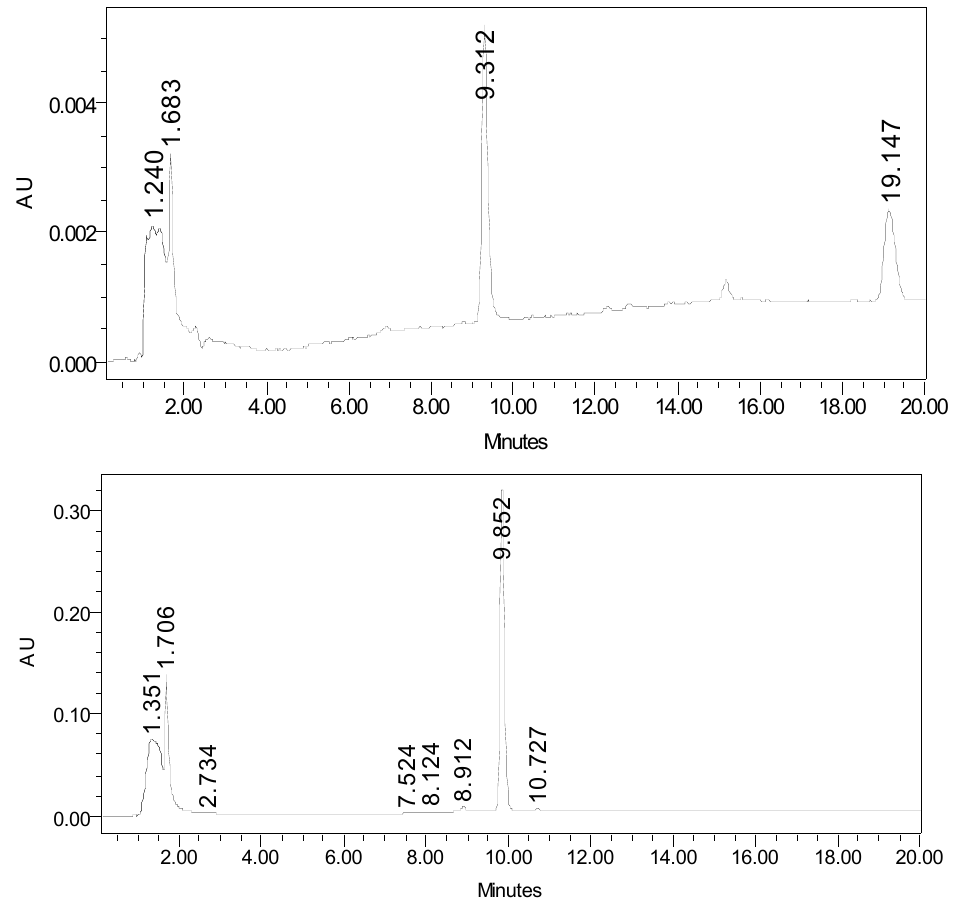
Figure 1. HPLC chromatogram of 1-AP, atrazine and their photoproducts. Column: Lichrospher® 100 RP-8 (25cmX4.0mm I.D., 5 µm), flow rate: 1.0 mL/min, gradient elution: acetonitrile/water mixture (40/60 to 90/10 v/v from 0 to 10 min, held at 90/10 v/v from 10 to 18 min, then 90/10 to 40/60 v/v from 18 to 20 min). (a) is the HPLC chromatogram of 1-AP and its photoproducts: peak at 9.3 min is 1-AP; peaks at 1.24 and 1.68 min are HS, and others are its photoproducts. Figure 1 (b) is the HPLC chromatogram of atrazine and its photoproducts: peak at 9.8 min is atrazine; peaks at 1.35 and 1.70 min are HS, and others are its